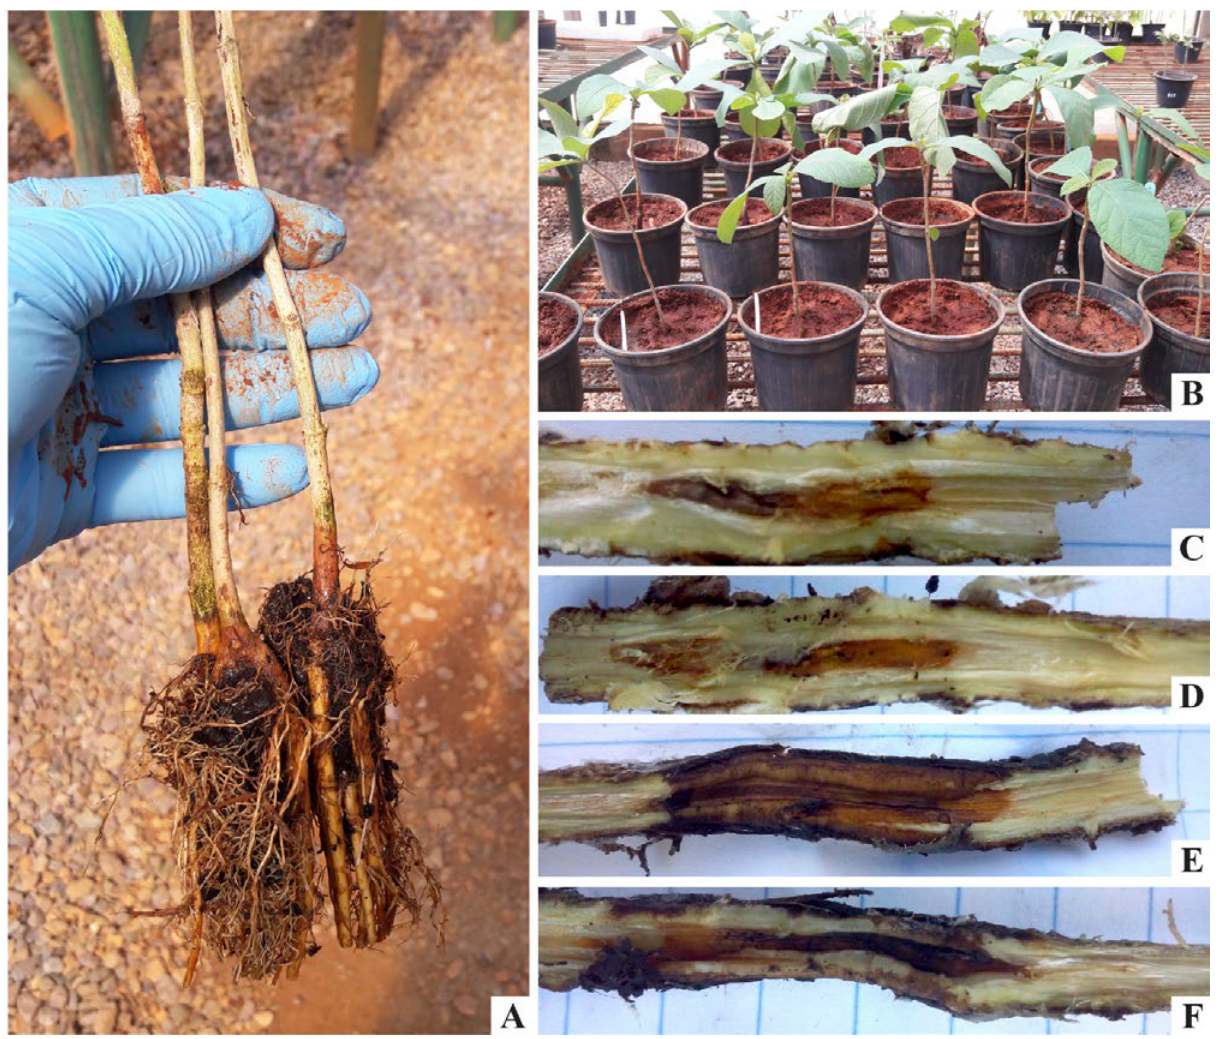
Figure 3. Pathogenicity assay of one Fusarium oxysporum isolate (‘FusTeca2’) from teak ( Tectona grandis ): seedlings of teak (80 d after transplanting) were inoculated via root-dipping using microconidium suspension (a). Typical damage induced by the F. oxysporum isolate in teak seedlings (b). Overview of teak seedlings in the pathogenicity assay with the F. oxysporum isolate (c). Distinct levels of vascular browning symptoms after inoculation of teak seedlings with the F. oxysporum isolate (c, d, e, and